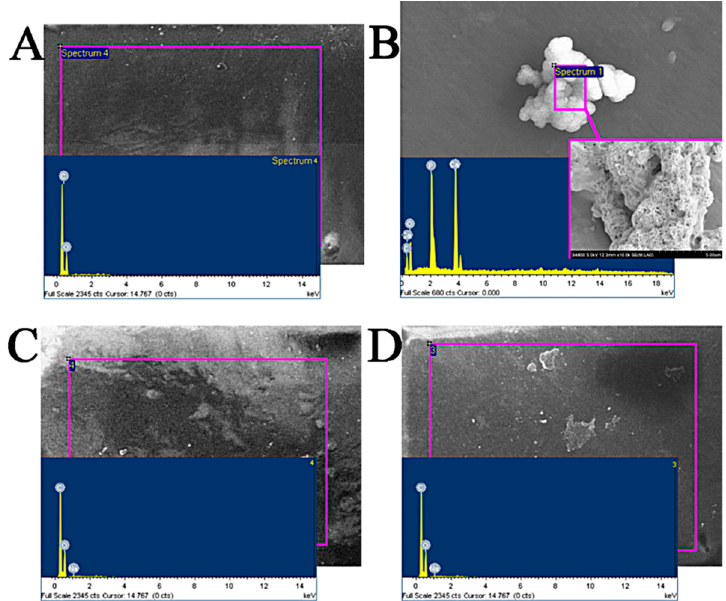
Figure 6. The results of EDS. ( A ) Deionized water group; ( B ) SBF group; ( C ) STF group; ( D ) artificial tears group. Table 3. The data of element content by EDS.